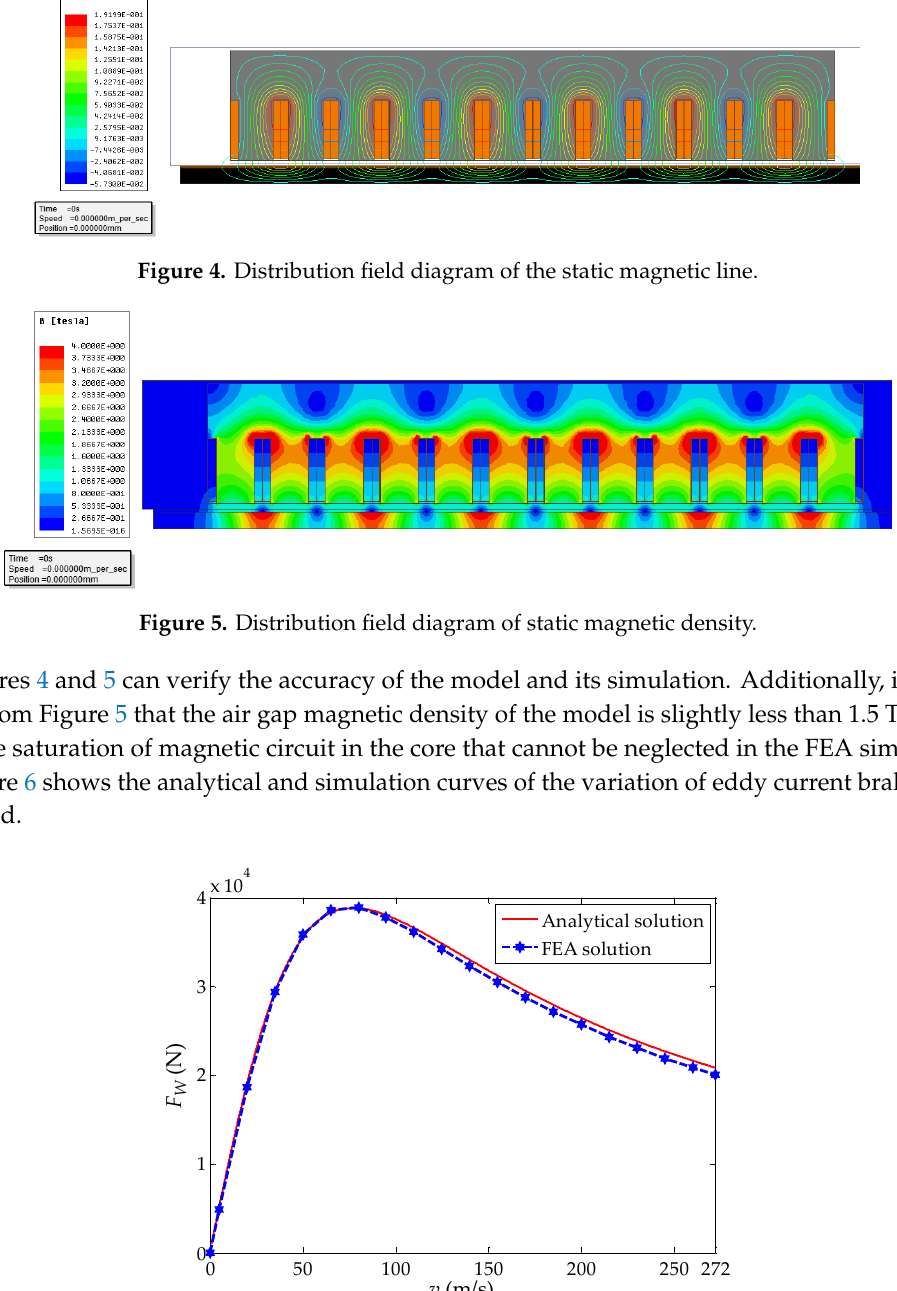
b s Figure 3. FEA model of eddy current braking.